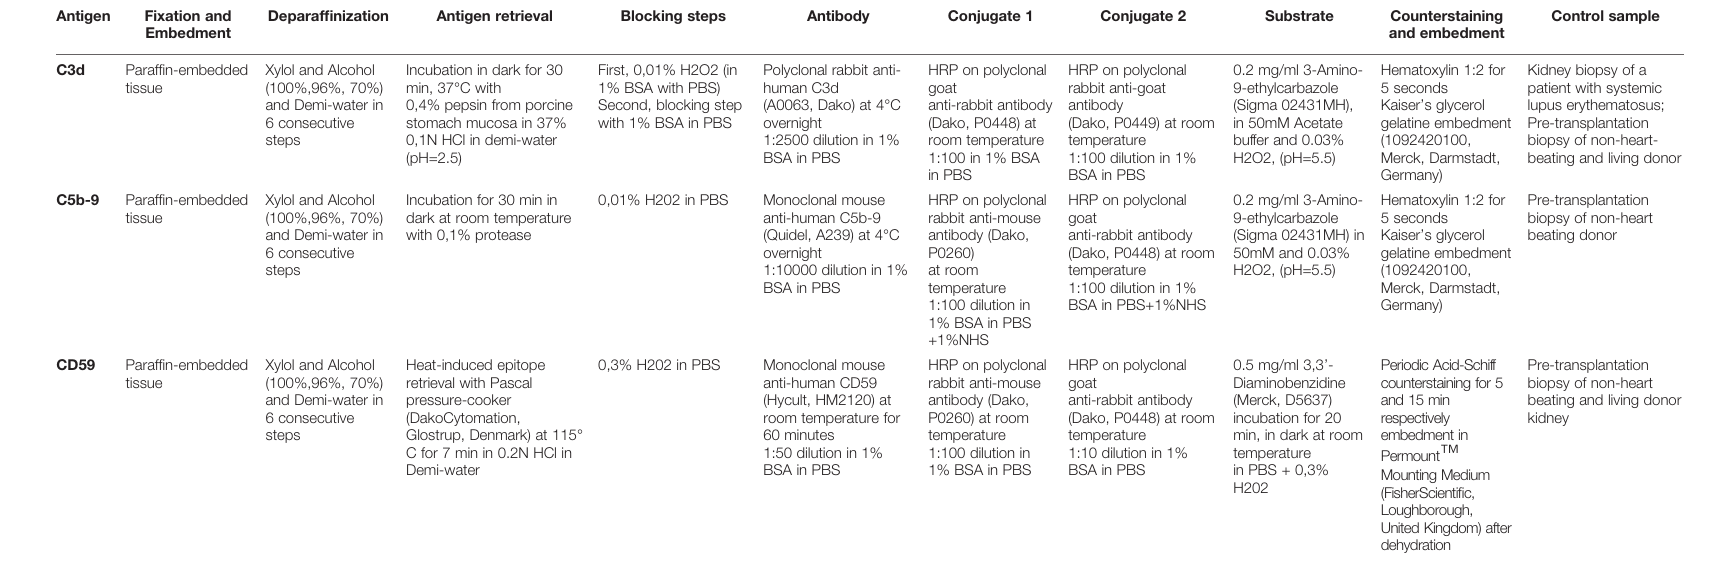
TABLE 2 | Complement factor staining in biopsies from kidney transplant